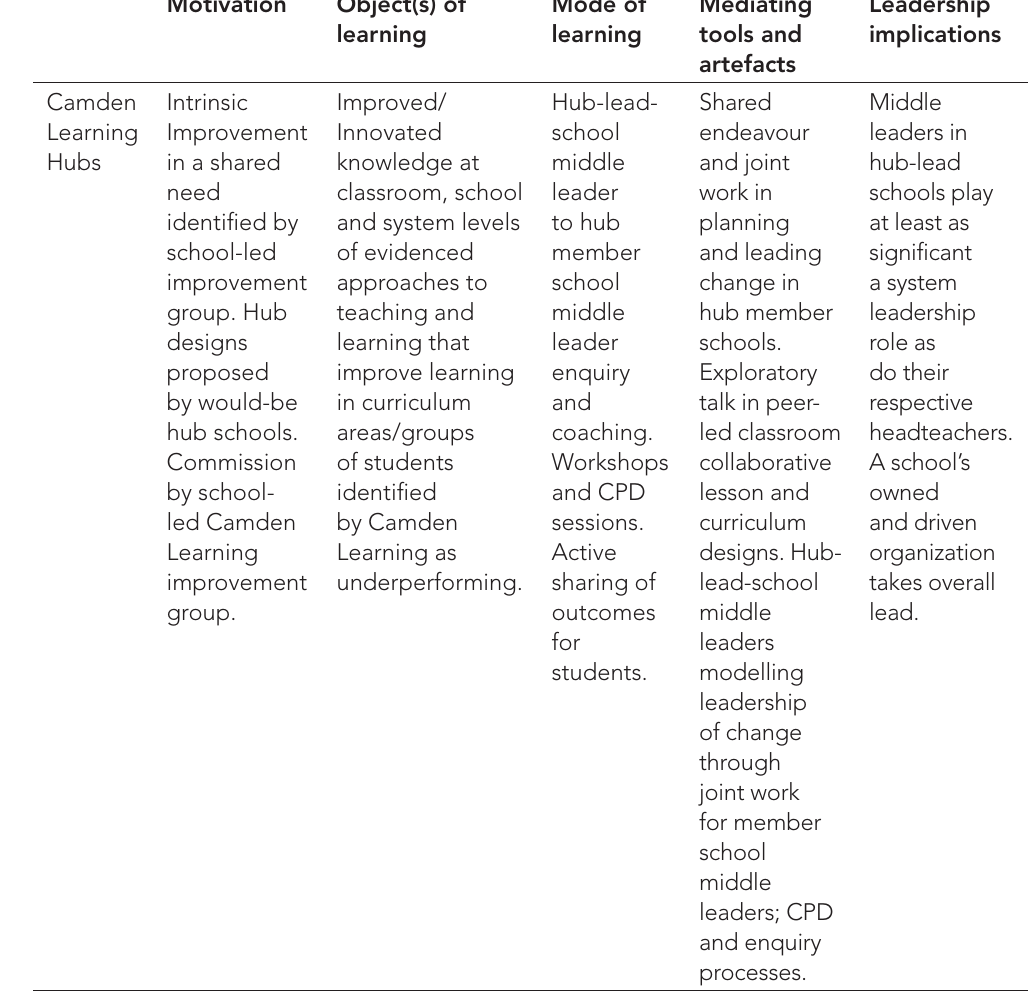
Table 3: Sociocultural classroom-, school- and system-level professional learning model – Stage